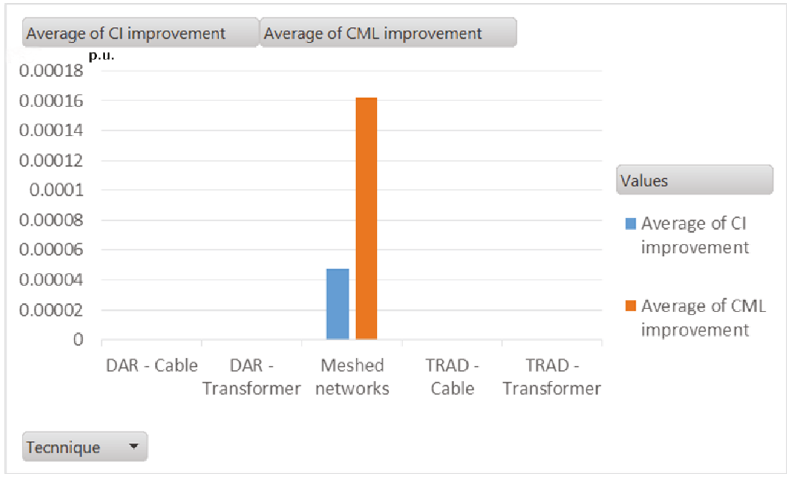
Figure 12: Average CML and CI improvement per technique; DECC4, 2015 –